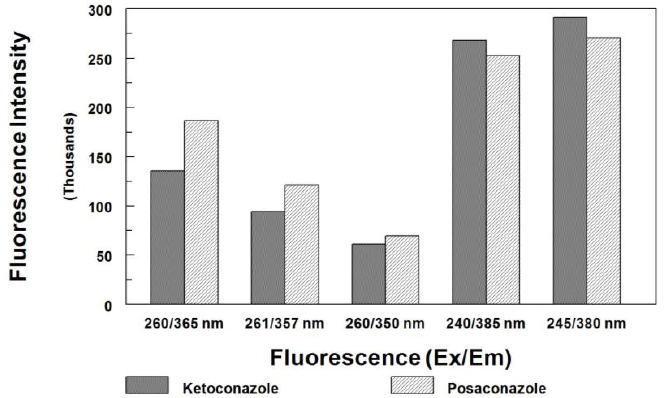
Figure 3. Comparison of fluorescence intensity for posaconazole (7.5 µg/mL) and ketoconazole (2